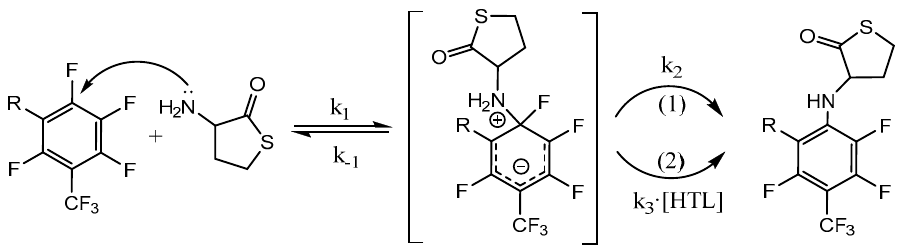
Figure 4. The possible mechanisms of reaction between PFT or PFX and HTL with (1) and without (2) basic catalysis by HTL excess. R = F or CF 3 .